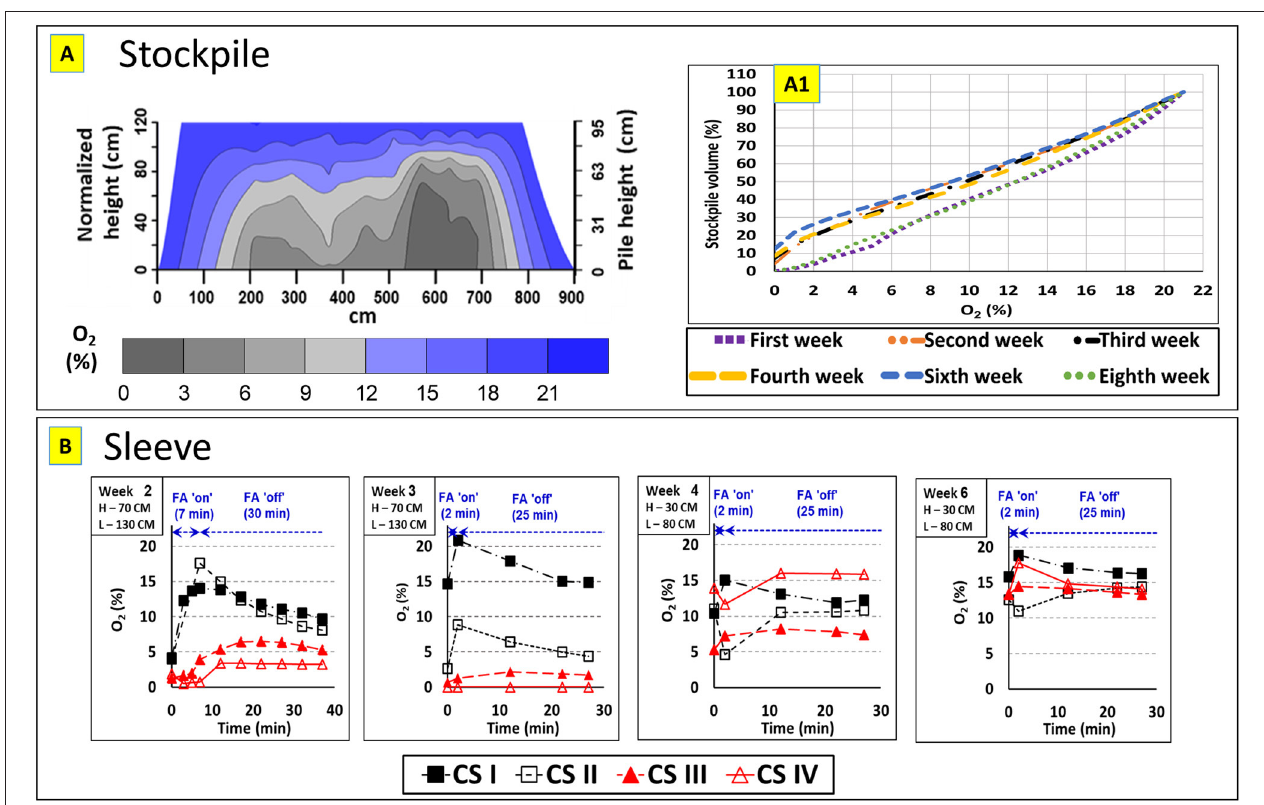
FIGURE 6 | Spatial–temporal variation of gas-phase oxygen (%). A contour map (week 1) and the cumulative volumetric percentage of oxygen are presented for the stockpile (A,A1) . Gas-phase oxygen in the sleeve is presented at time windows during which the blower was operated for 2–7min, and the air was sampled at time intervals up to 30min thereafter (B)